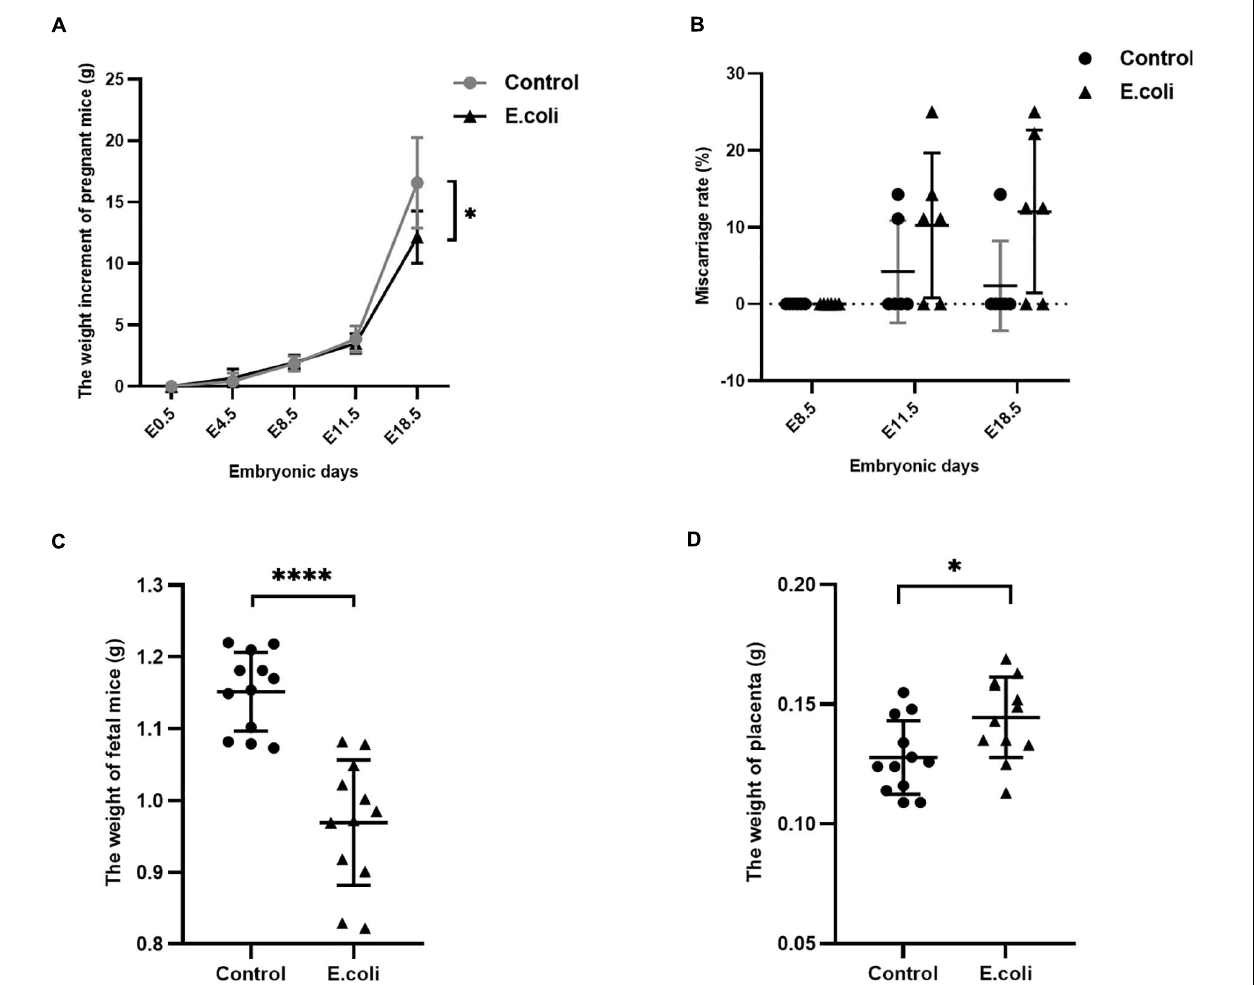
FIGURE 2 | Characteristics of the mother and fetus in mice in the study ( E. coli ) group and the control group. (A) Weight gain of pregnant mice in the study group and control group at E0.5, E4.5, E8.5, E11.5, and E18.5. The number of mice used for calculation of weight gain of pregnant mice in the control group at E4.5, E8.5, E11.5, and E18.5 were 17, 17, 11, and 6, respectively. The number of mice used for calculation of weight gain of pregnant mice in the study group at E4.5, E8.5, E11.5, and E18.5 were 18, 18, 12, and 6, respectively. (B) Miscarriage rate in the study group and control group at E8.5, E11.5, and E18.5. The number of mice used for calculation of miscarriage rate in the control group at E8.5, E11.5, and E18.5 are 6, 5, and 6, respectively. The number of mice used for calculation of miscarriage rate in the study group at E8.5, E11.5, and E18.5 are 6, 6, and 6, respectively. (C) Weight of fetus in the study group and control group at cesarean section ( n = 12). (D) Weight of the placenta in the study group and control group at cesarean section ( n = 12). Data are presented as mean ± standard deviation. Unpaired t -test was used for two-group comparisons of the weight gain, the weight of fetus, and the weight of the placenta. Mann-Whitney U -test was used for two-group comparisons of the miscarriage rate. ∗ P < 0.05, ∗∗∗∗ P < 0.0001.